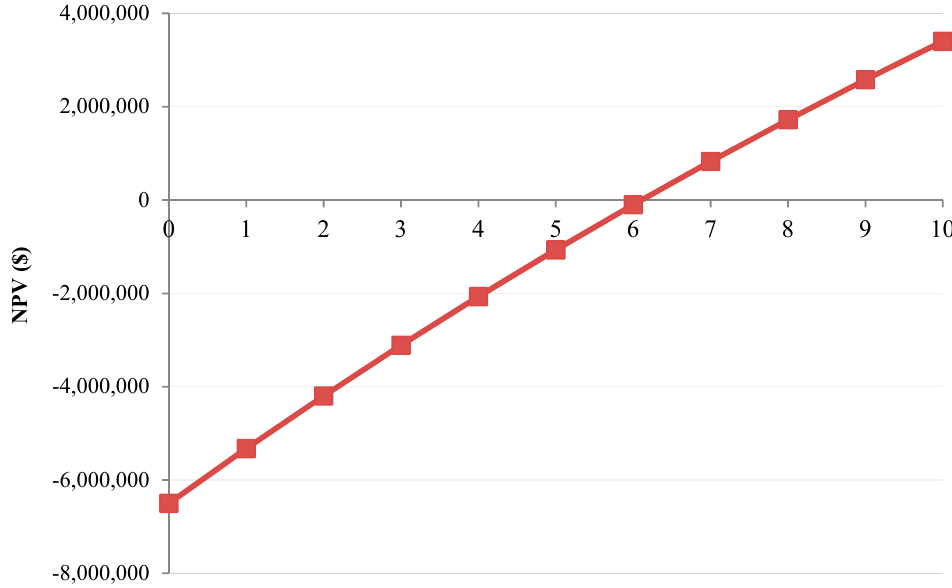
Figure 4. Net present value (NPV) of the economic performance of the proposed CCHP for 10 years operation.